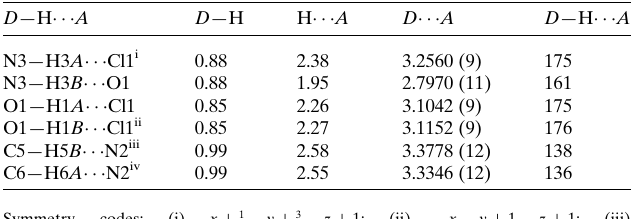
Table 2 Hydrogen-bond geometry (A˚ , (cid:5) ) for the room-temperature structure.